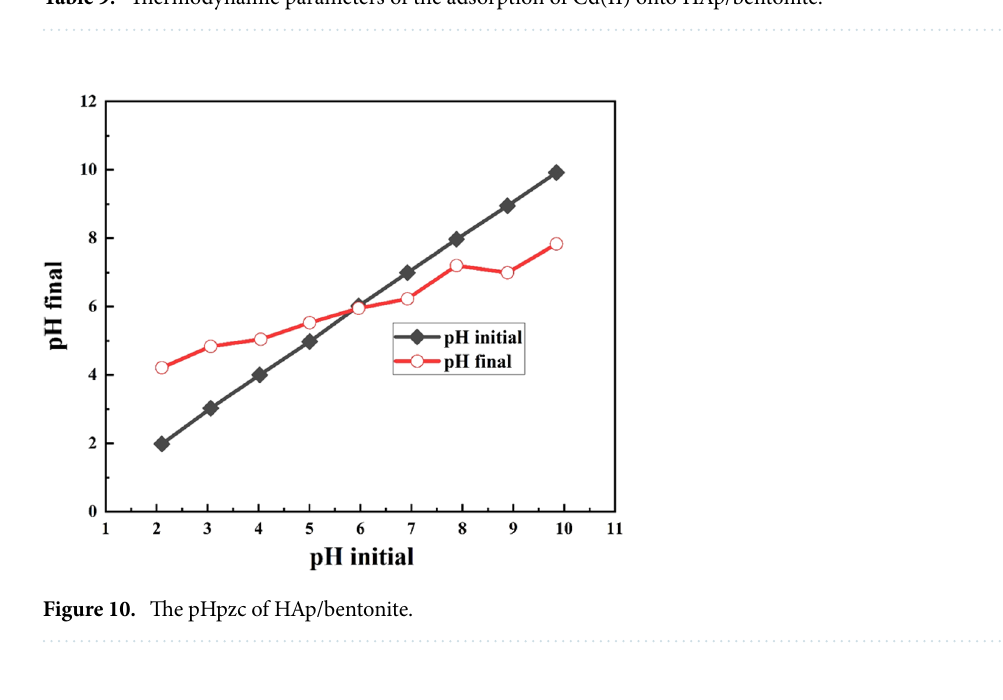
Table 9. Thermodynamic parameters of the adsorption of Cd(II) onto HAp/bentonite.